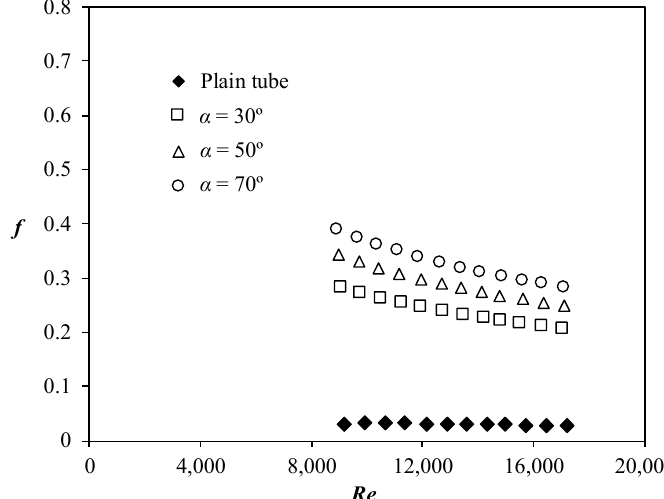
Figure 8. Friction factor for various attack angles.